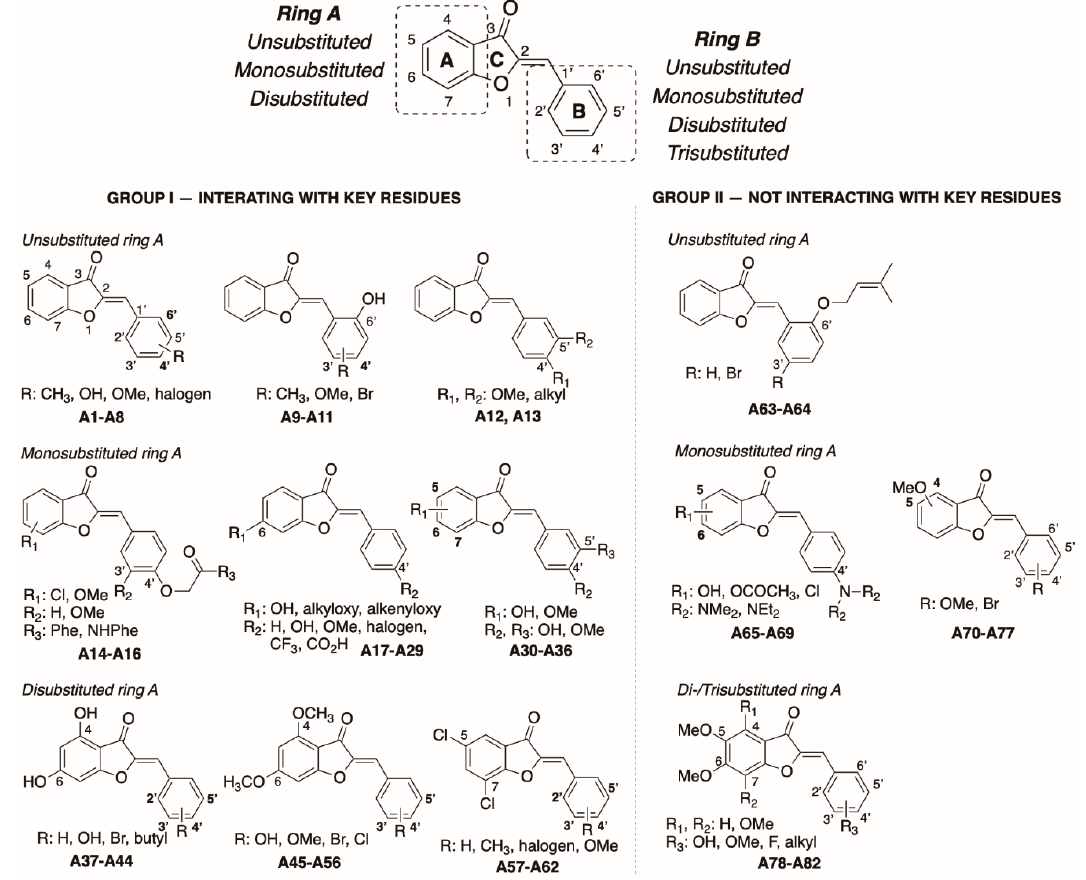
Figure 4. Classification of 82 aurone derivatives.